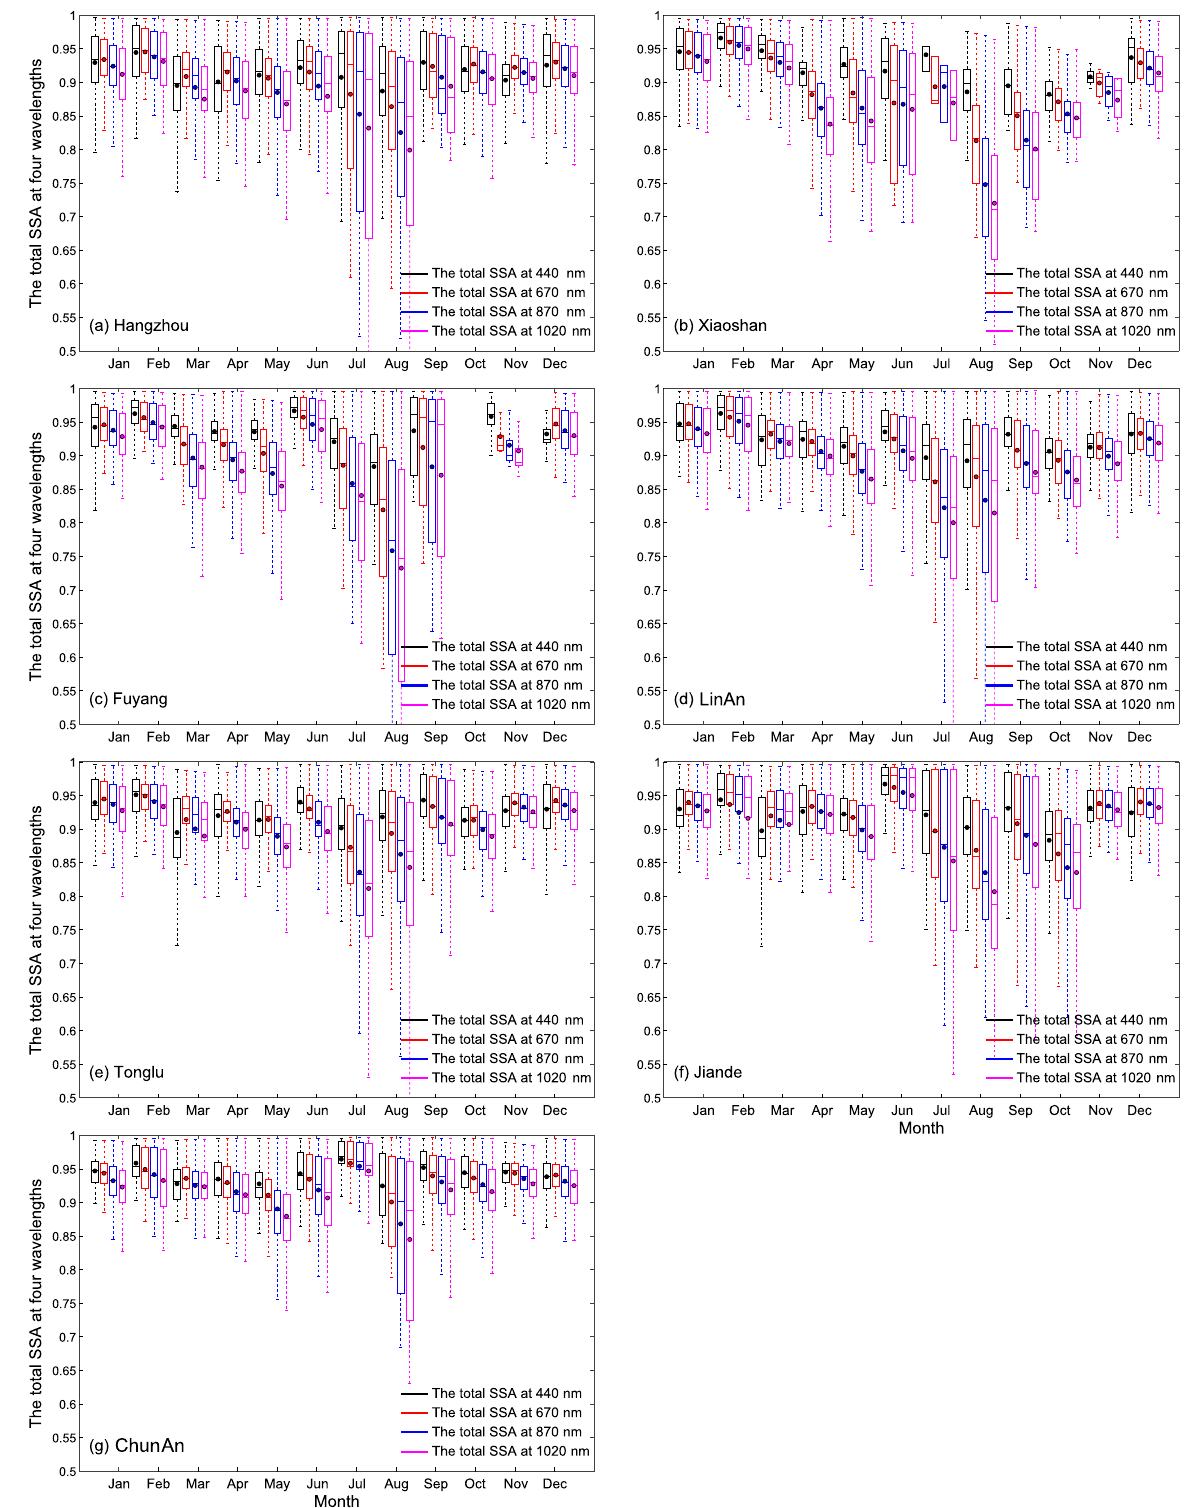
Figure 4. Variations in the single-scattering albedo at 440, 670, 870 and 1020nm at (a) Hangzhou, (b) Xiaoshan, (c) Fuyang, (d) LinAn, (e) Tonglu, (f) Jiande and (g) ChunAn. See Fig. 3 for an explanation of the